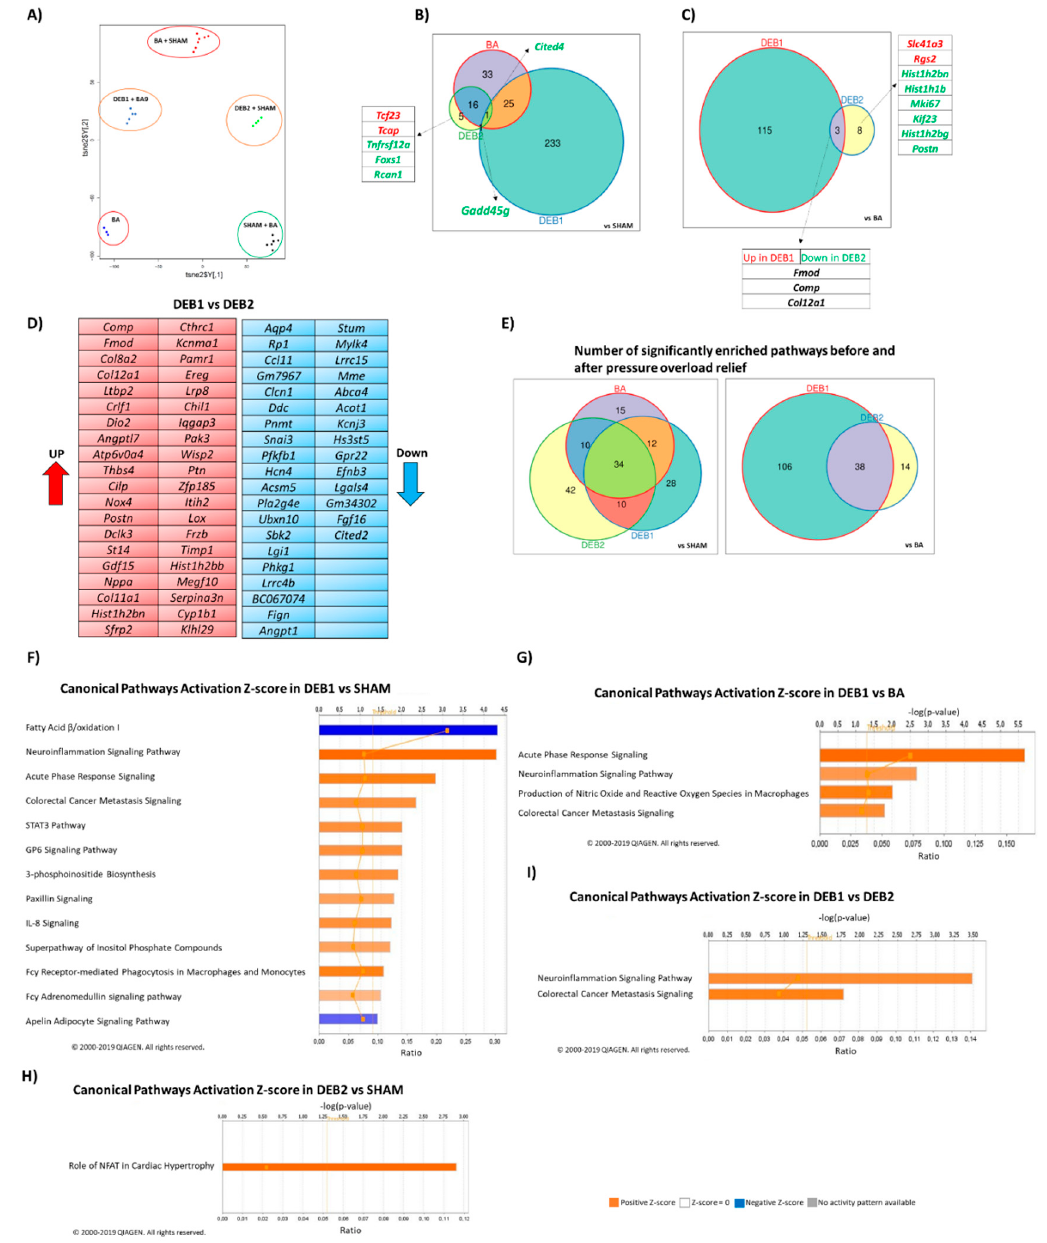
Figure 2. Two-dimensional t-SNEi projection of all initial LV samples (SHAM, BA, and DEB subgroups) and samples from animals with nine weeks of banding (Table S1) ( A ). Di ff erentially expressed transcripts in BA, DEB1, and DEB2 groups when compared to SHAM ( B ), in DEB1 and DEB2 when compared to BA group ( C ), and the top expressed transcripts between the two debanding subgroups ( D ). When the number of di ff erentially expressed transcripts was superior to 15, we referred to it in supplementary data as an excel file format (Data S1). The cut-o ff for di ff erentially expressed transcripts was set for a false discovery rate (FDR) of ≤ 0.05, using Benjamini-Hochberg calculation, and a Log2FC ≤ − 1 (blue transcripts) or Log2FC ≥ 1 (red transcripts). Venn diagram displaying the number of common and exclusive pathways between the four groups ( E ). Canonical pathways activation Z-score analysis in DEB1 vs. SHAM ( F ), DEB1 vs. BA ( G ), DEB2 vs. SHAM ( H ), and DEB1 vs. DEB2 ( I ). Pathways with Z-score ≥ 1.5 were predicted to be active (orange bars), and pathways with Z-score ≤ 1.5 were predicted to be inhibited (blue bar). The threshold for significance was –Log( p -value) ≥ 1.3 (Threshold line) (Fisher’s Exact Test p -value). The orange line represents the ratio between Up-regulated and Down-regulated transcripts. Analysis performed using Ingenuity Pathways Analysis Software,